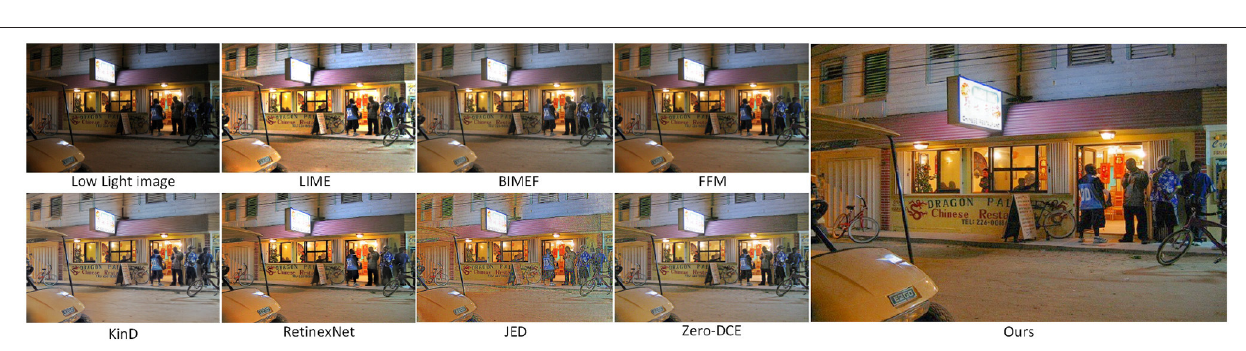
FIGURE 9 | Comparison of various low light image enhancement methods using night images from the VV dataset.